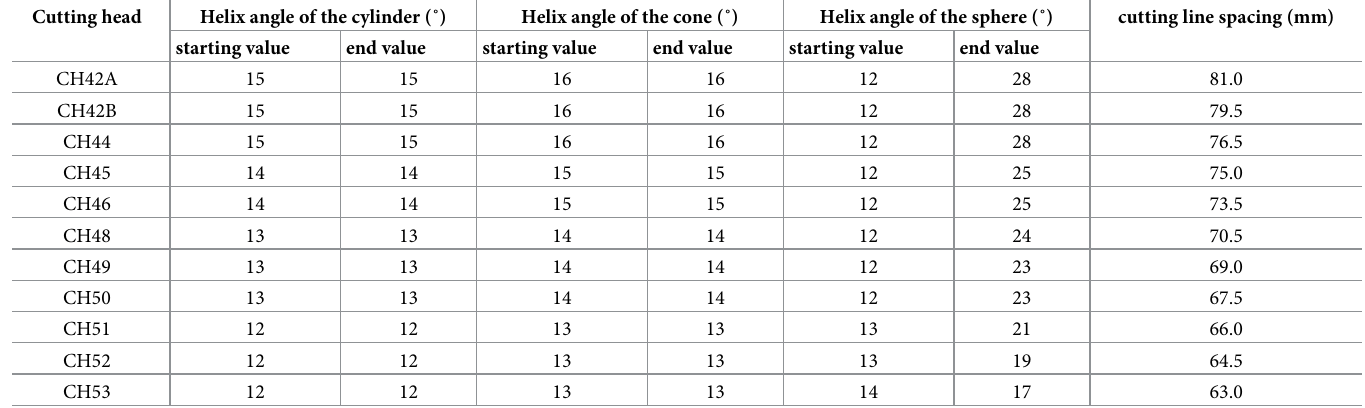
Table 1. Helix angle and cutting line spacing of 3-helices cutting head.